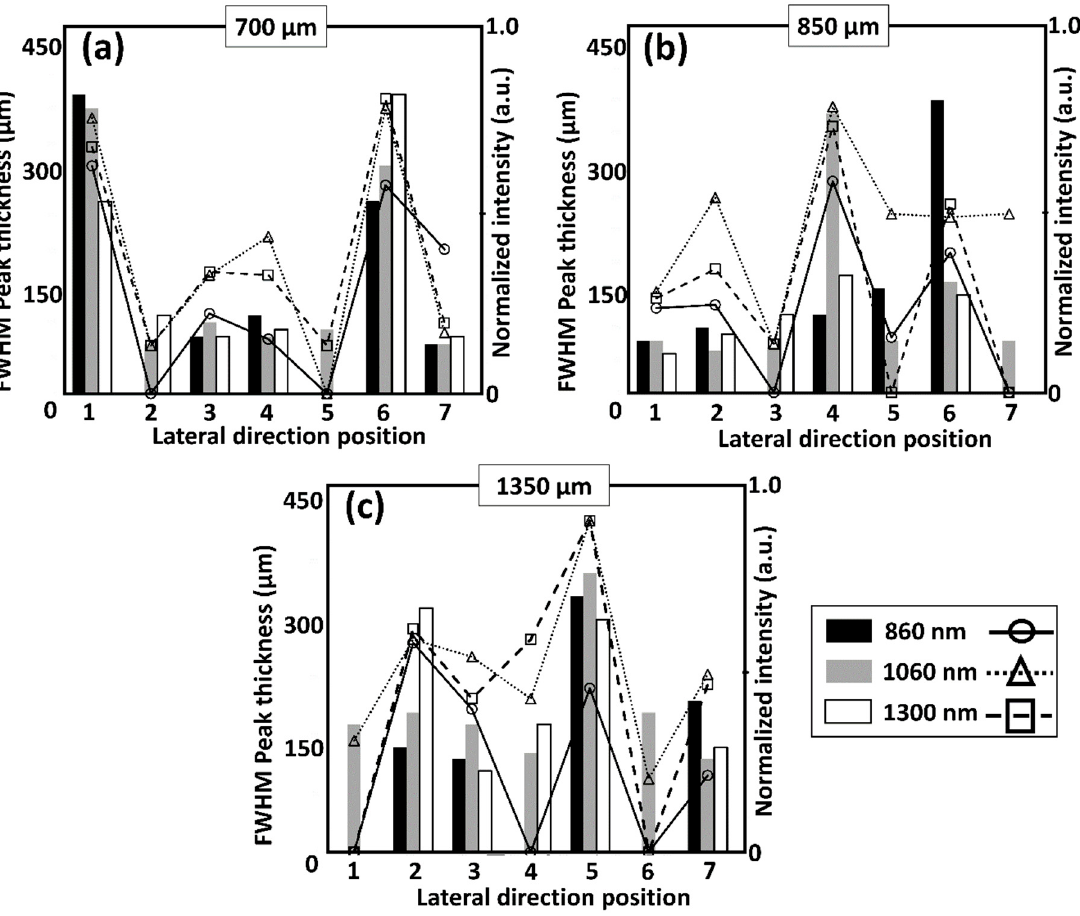
Figure 4. The numerical quantifications for thickness and normalized intensity correspond to intra-cochlear microstructural positions (indicated by 7 uniform points) in each wavelength range of Figure 3. ( a ) FWHM thickness and the normalized intensity values correspond to seven lateral direction positions of all three OCT systems selected from 700 µ m depth range; ( b ) FWHM thickness and the normalized intensity values correspond to seven lateral direction positions of all three OCT systems selected from 850 µ m depth range; ( c ) FWHM thickness and the normalized intensity values correspond to seven lateral direction positions of all three OCT systems selected from 1350 µ m depth range.